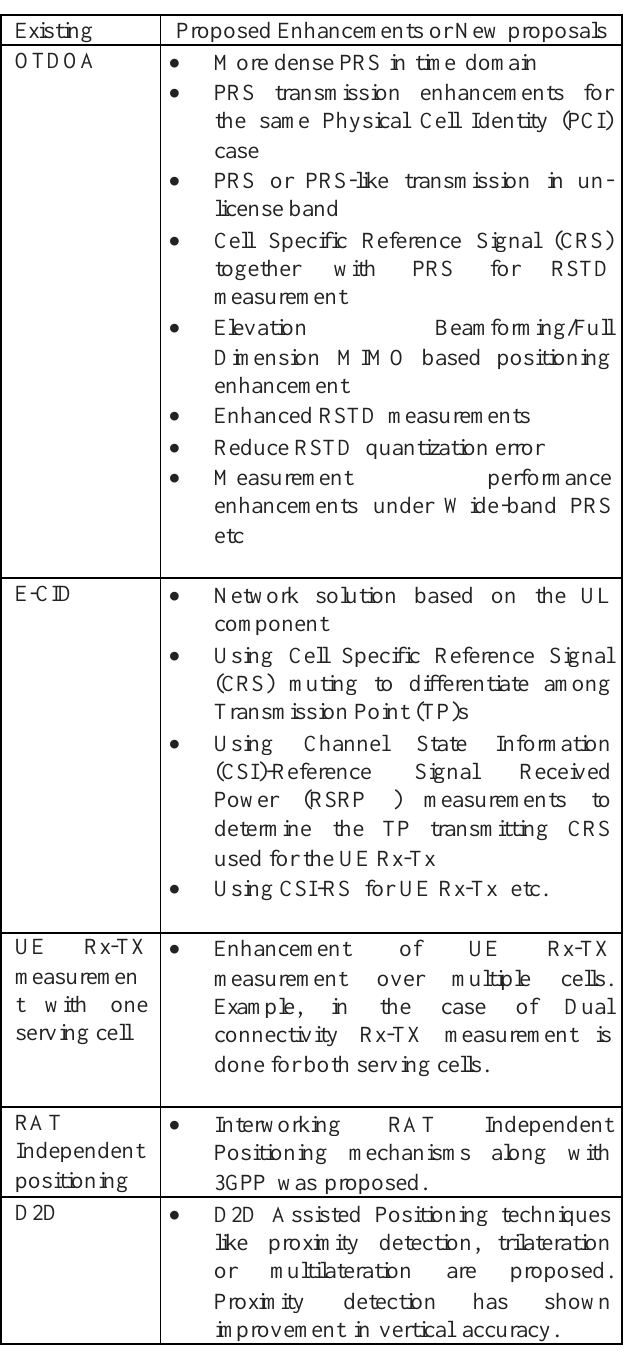
Table 1: Proposed Enhancements for